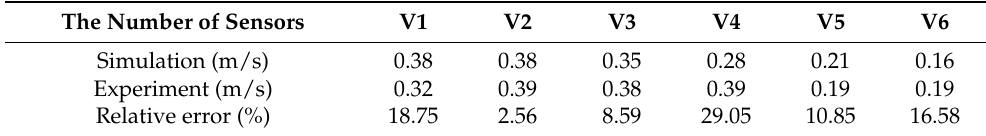
Table 3. Comparison between the simulation values and experiment values of the air velocity in the ventilation duct.